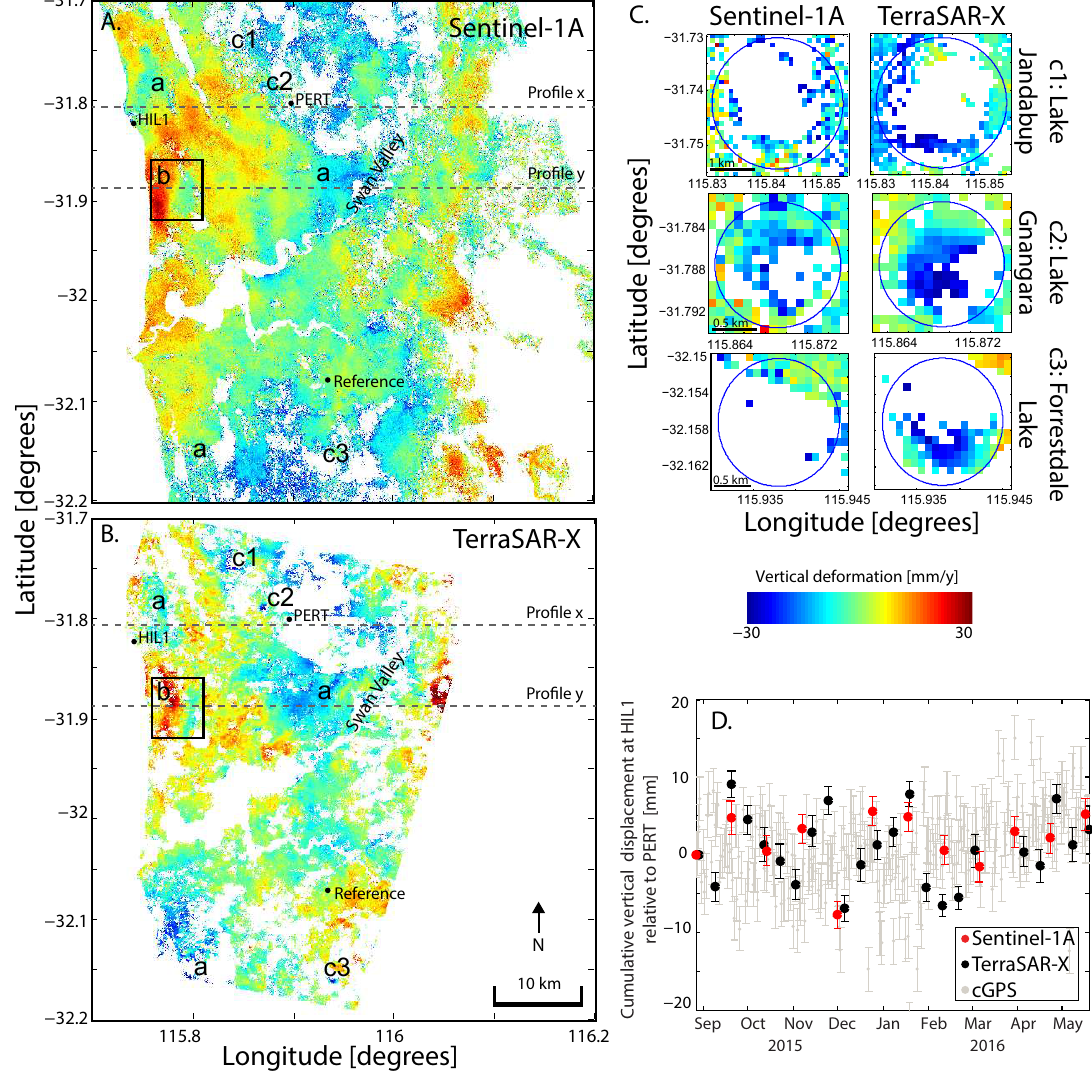
Figure 4. Deformation rate-maps for ( A ) 11 consecutive Sentinel-1A interferograms covering 27 August 2015–17 May 2016 and ( B ) 21 consecutive TerraSAR-X interferograms spanning 29 August 2015– 19 May 2016. Deformation measurements are relative to the reference shown in (A,B). Locations (a), (b) and (c1, c2, c3) show areas of displacements described in the text: (a) broad (>5 km wide) subsidence at up to 15 mm/y; (b) elongated regions of adjacent relative uplift and subsidence; and (c) localised ( ∼ 2 km wide), rapid (greater than 20 mm/y) subsidence coincident with wetland areas. The dashed lines show the locations of the profiles drawn in Figure 5. ( C ) Zoomed in sections showing subsidence in three wetland areas: Lake Jandabup (c1 in (A)), Lake Gnangara (c2 in (A)) and Forrestdale Lake (c3 in (A)). Blue circles show approximate boundaries of each wetland. ( D ) Time-series of cumulative vertical displacement measured at continuous GPS station HIL1 relative to continuous GPS station PERT (locations labelled in (A,B)). GPS data are from the Nevada Geodetic Laboratory, and InSAR displacements are calculated using the method described in the